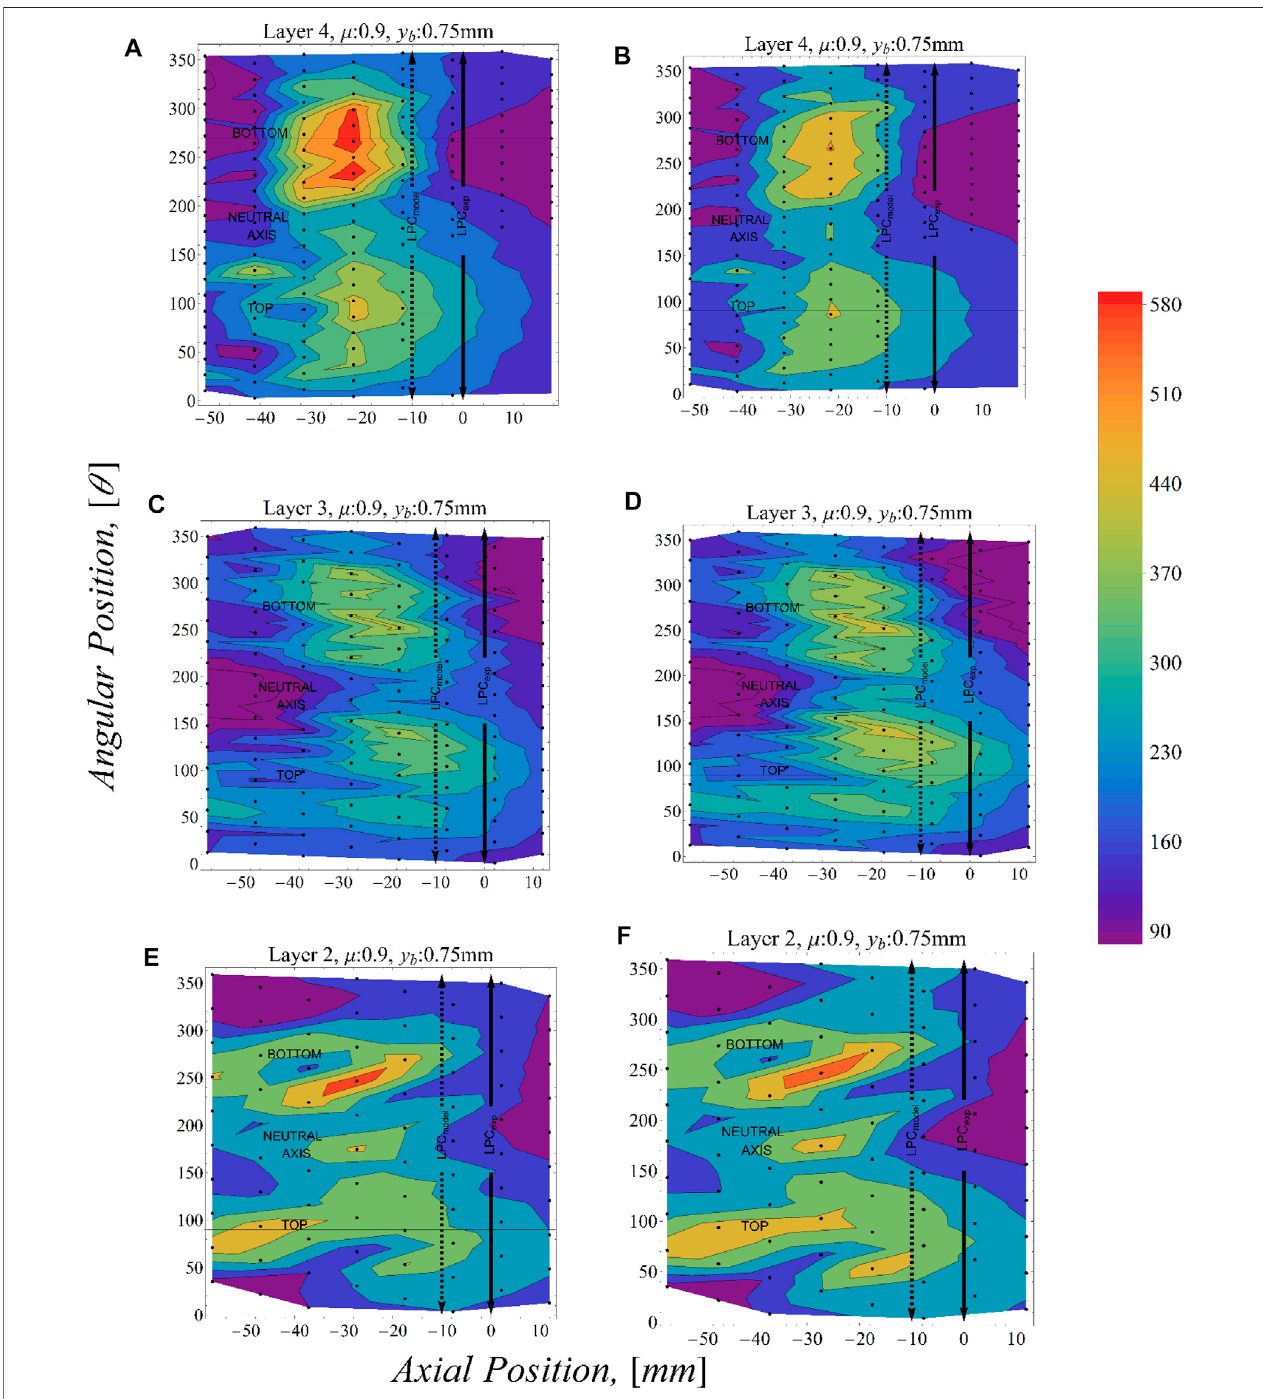
FIGURE 7 | Distribution of maximum principal stresses (in MPa) for a bending amplitude of 0.75 mm. (A,C,E) β 0 + Δ β and (B,D,F) β 0 − Δ β .